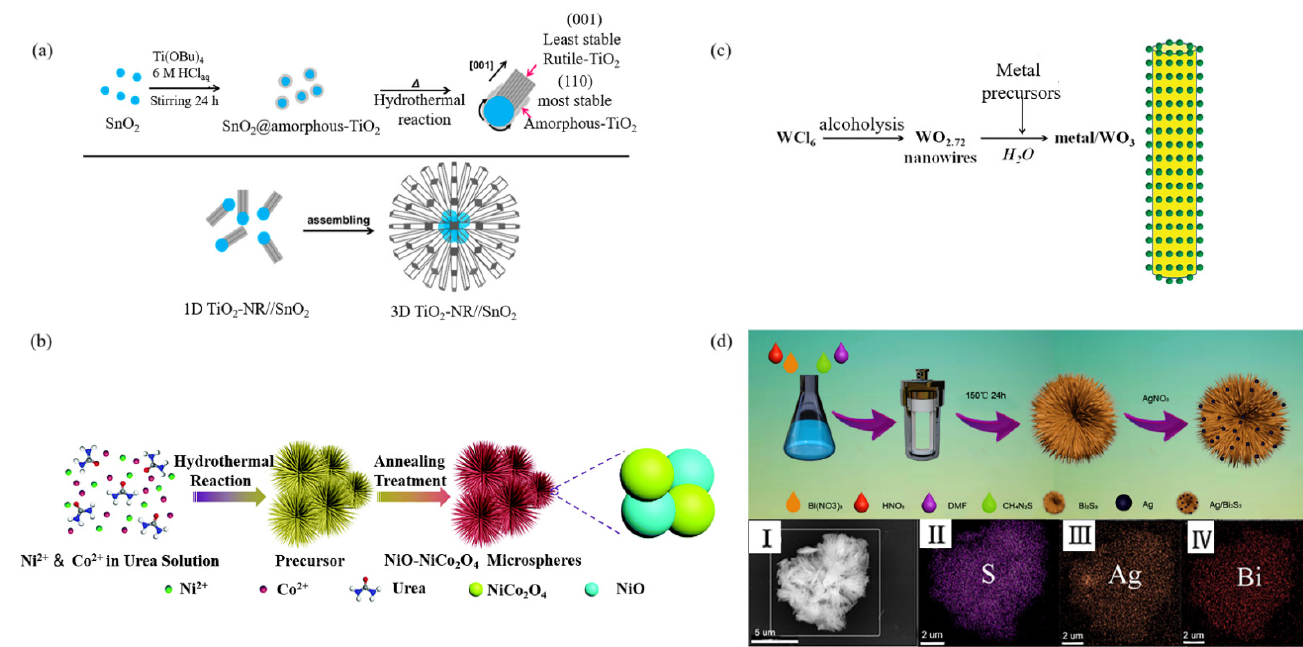
Figure 5. Examples of decorated urchin-like micro-/nanoparticles depending on reaction mechanism: ( a ) A schematic representation of the formation and self-assembly of TiO 2 -NR//SnO 2 [72] (Reprinted with permission from ref [72]). ( b ) Schematic illustration of the formation of NiO–NiCo 2 O 4 microspheres through a two-step method [73] (Reprinted with permission from ref [73]. Copyright 2019 The Royal Society of Chemistry). ( c ) Schematic procedure for in situ loading of metal particles on WO 3 [74] (Reprinted with permission from ref [74]. Copyright 2012 American Chemical Society). ( d ) Schematic diagram of the preparation of the urchin-like Bi 2 S 3 /Ag nanostructures and the EDS spectrum of the Ag/Bi 2 S 3 (I), and the elements of S, Ag, and Bi of the Ag/Bi 2 S 3 (II–IV) [75] (Reprinted with permission from ref [75]. Copyright 2021 American Chemical Society).